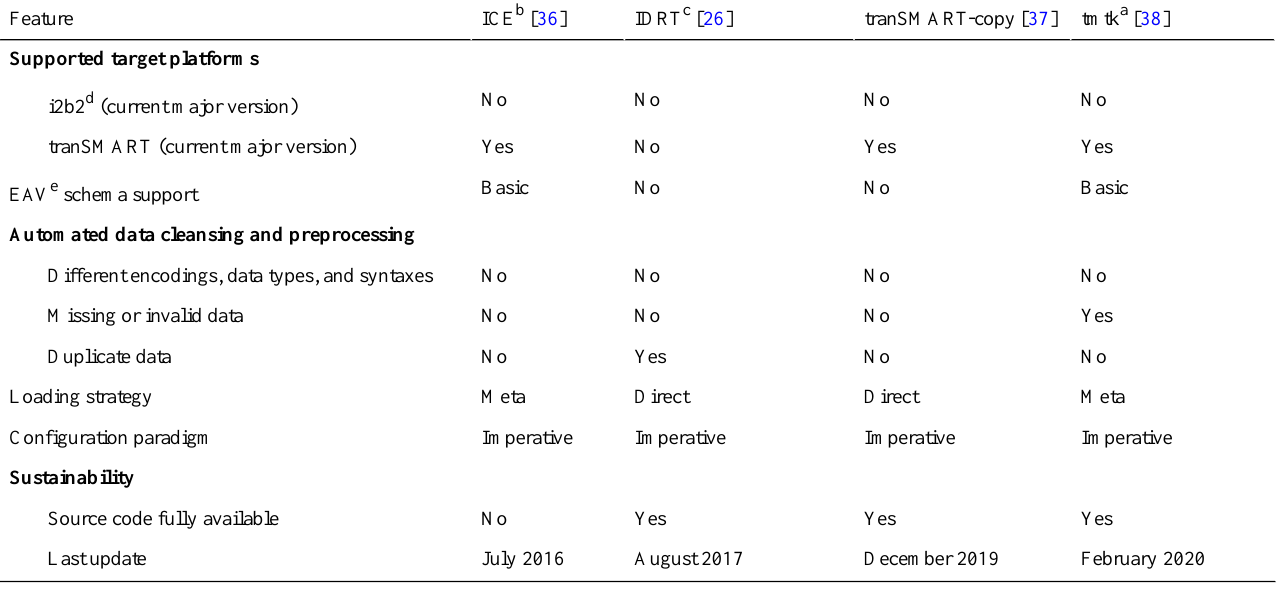
Table 7. Comparison of extraction-transformation-loading tools: Integrated Curation Environment, Integrated Data Repository Toolkit, transmart-copy, and tmtk a